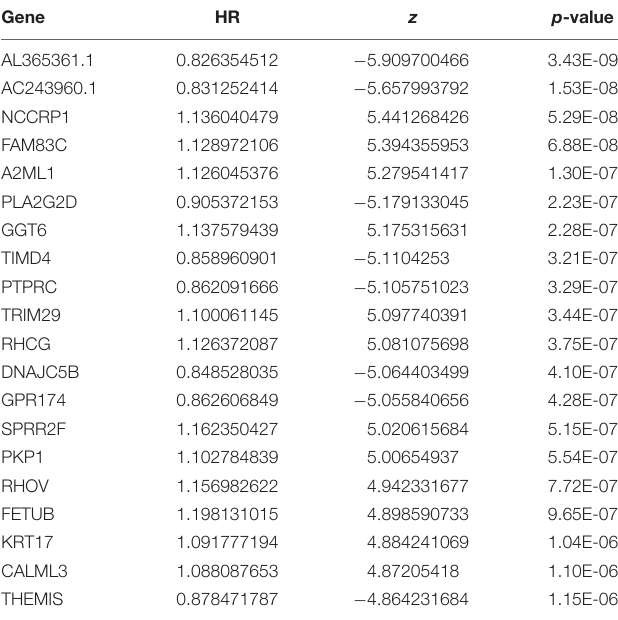
Frontiers in Genetics |